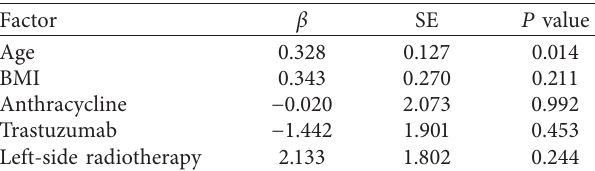
Figure 1: LVEF (a) and GLS (b) in breast cancer patients with metabolic syndrome and noncancer patients with metabolic syndrome. Table 2: Multivariate analysis for LVEF in breast cancer patients with metabolic syndrome after treatment.